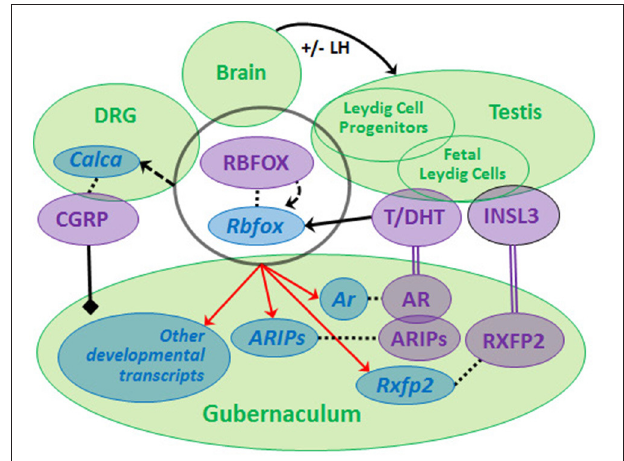
FIGURE 2 | We propose that a neuro-hormonal signaling network regulates testicular descent via direct and indirect interactions among multiple target tissues (green circles). Development of the gubernaculum requires androgen (T, DHT) and insulin-like 3 (INSL3) binding, respectively, to RXFP2 and AR (together with AR-interacting proteins, ARIPs), and regulation by calcitonin gene-related peptide (CGRP). LH regulates Leydig cells during later phases of gestation. Rbfox/RBFOX transcripts/proteins are expressed (overlapping black circle) at all levels of the system with evidence for autoregulation (curved dashed arrow) and for regulation (solid straight arrow) by androgens [data from ( 46, 60), Barthold et al., unpublished]. RBFOXs regulate alternative splicing of Calca (dashed straight arrow) in dorsal root ganglia (DRG) to generate CGRP, which is released by sensory nerves innervating the gubernaculum (solid black line/diamond). Ar, Rxfp2 and other developmental transcripts are predicted experimental and/or computational RBFOX targets (as denoted by red